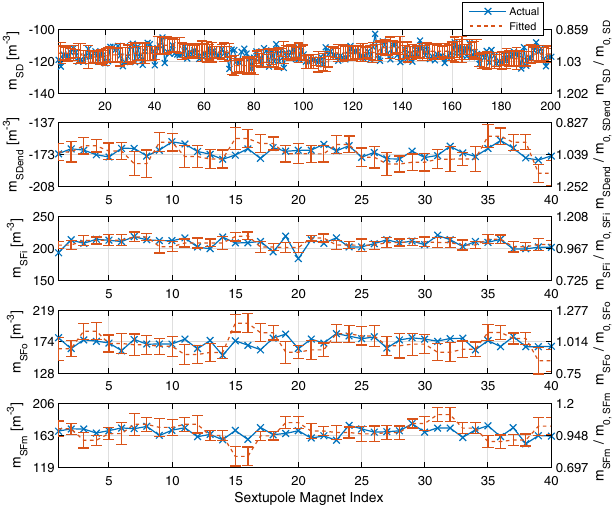
FIG. 7. Introduced sextupole magnet errors and found sextu- pole circuit settings from a single error seed. The error bars are the standard deviation of 10 error seeds. The found settings do not directly correspond to the average magnet errors in a circuit, despite this the fit is able to reproduce the chromatic functions (see Fig.